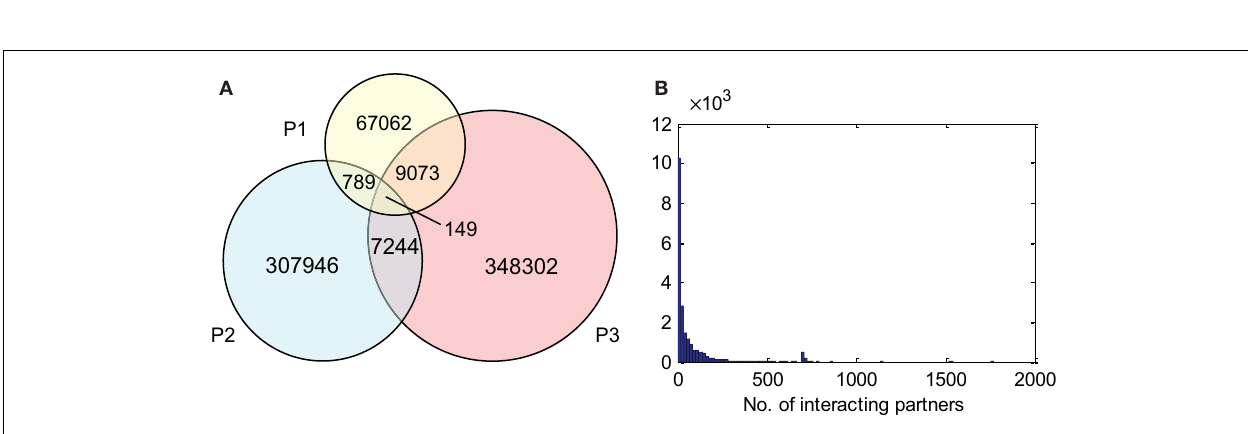
FIGURE 6 | (A) The relationship between different prediction subsets. (B) Histogram showing degree distribution (number of interacting partners for each protein) for